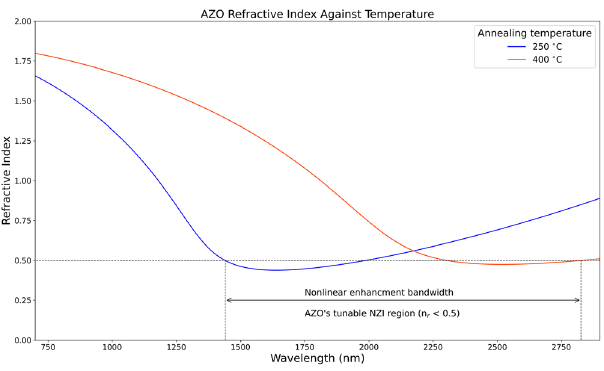
Fig. 6 Optical properties engineering via fabrication means. Refractive index dispersions of AZO thin fi lms are reported for two different annealing temperatures (250 °C, blue curve on the left; and 400°C, red curve on the right). The data in this plot have been repurposed from